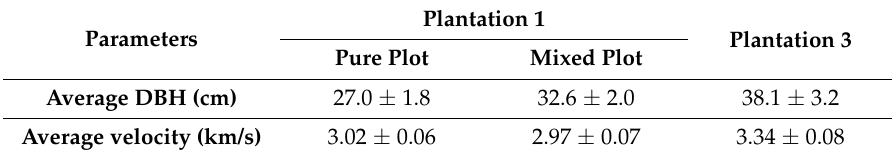
Figure 9. Propagation velocity of the standing trees (C T ) versus the propagation velocity of the logs (C L ), for Plantation 3.